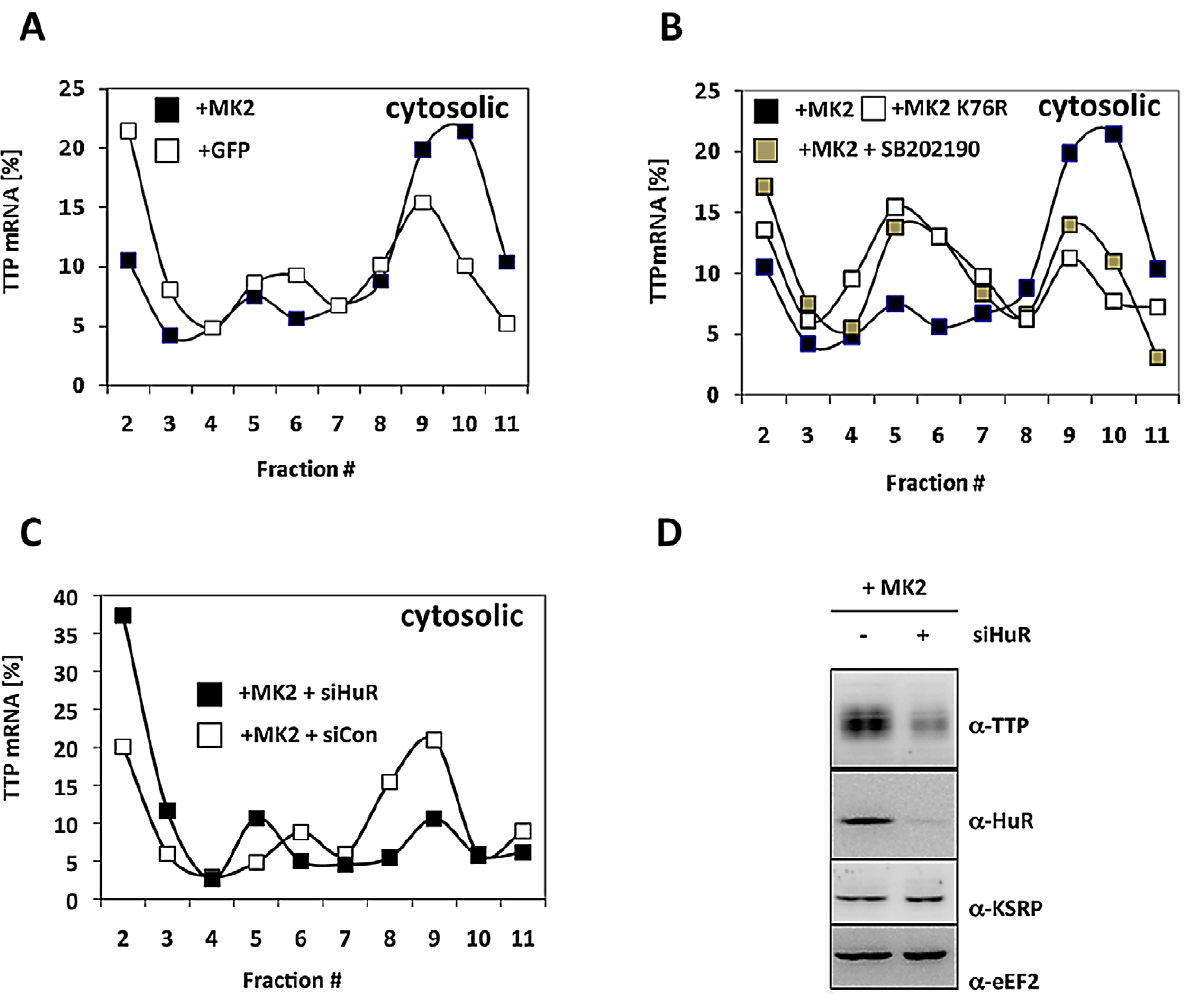
Figure 6. MK2- and HuR–dependent translational regulation of TTP mRNA. A) Cytosolic polysomal profiles for TTP mRNA of LPS-stimulated MK2-rescued and GFP-transduced macrophages. B) Cytosolic polysomal profiles of TTP mRNA depend on catalytic activity of p38 and MK2. C) siRNA mediated knockdown of HuR (MK2 + siHuR) inhibits MK2-dependent translation of TTP mRNA. D) Knockdown of HuR decreases LPS-induced TTP expression. Western blots of macrophage lysates prepared 4 h after